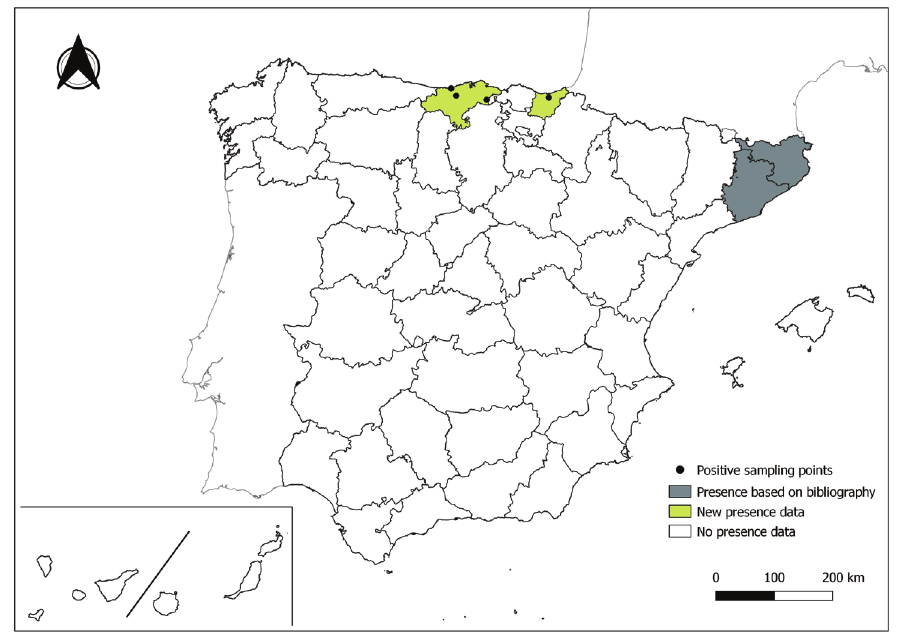
Figure 5. Distribution of Phlebotomus mascittii in Spain.